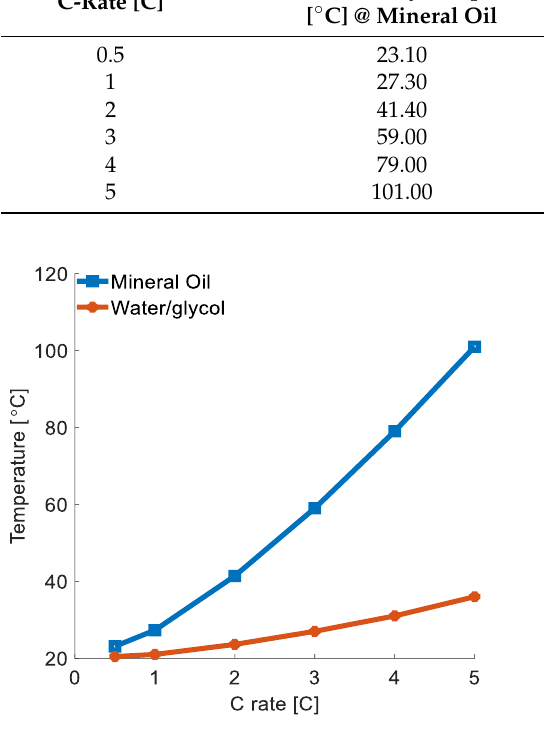
Figure 11. Predicted battery temperature profiles at different C rates.